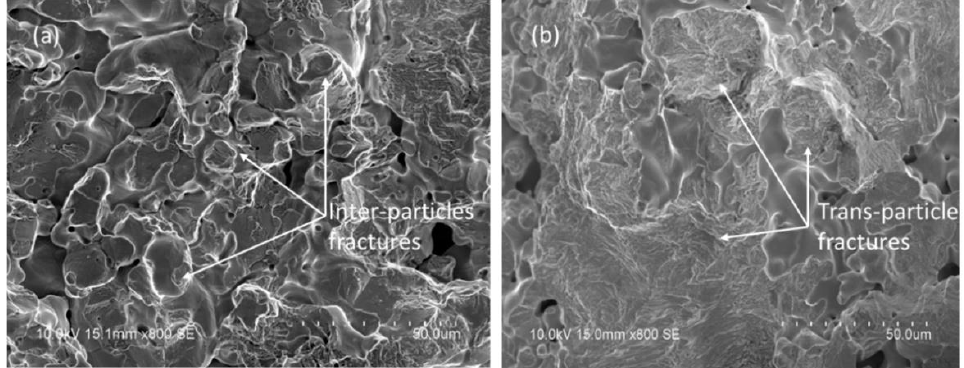
Figure 8. Fatigue fracture surfaces of powder metallurgy alloy steels: ( a ) Astaloy CrM exhibiting inter-particle fracture through the channel constructed by sintering necks, and ( b ) Distaloy AE with trans-particle fracture occurred in the interior of base